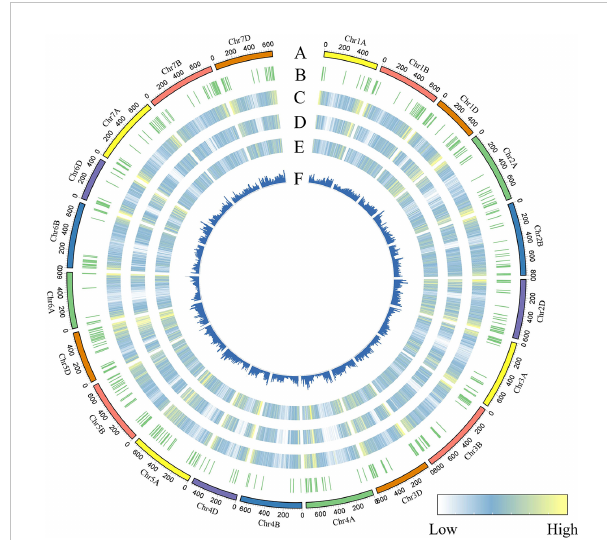
FIGURE 4 CIRCOS visualization of different data at the wheat genome-wide level. (A) Karyotype of the wheat genome. (B) Location of variant genes related to disease resistance. (C) Gene content density